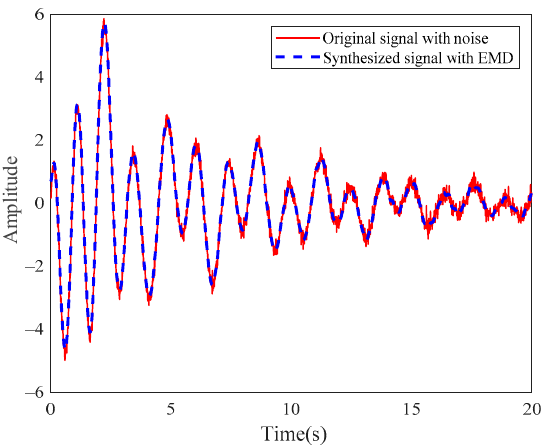
Figure 11. Comparison of c EMD ( t ) with signal B. The curve of c EMD ( t ) is smooth and extremely coincidence with that of signal B, which indicates that c EMD ( t ) has retained the dominant modes of the original DLFO signal. And c EMD ( t ) is conducive to modal identification by SSI and Prony following. Using the SSI method and Prony algorithm to identify c EMD ( t ), the estimated modal parameters are shown in Tables 6 and 7, respectively. Table 6. Modal parameters of signal B identified with SSI approach. Table 7. Modal parameters of signal B identified with Prony approach